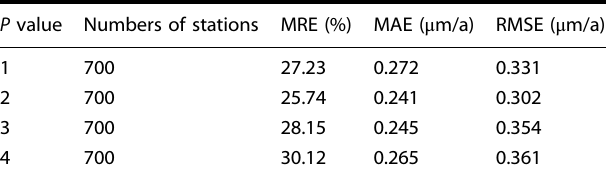
Fig. 5 The atmospheric corrosion map of China with powers of 1, 2, 3, and 4. a n = 1; b n = 2; c n = 3; d n = 4. Table 3. The MRE, MAE, and RMSE of interpolation results by cross